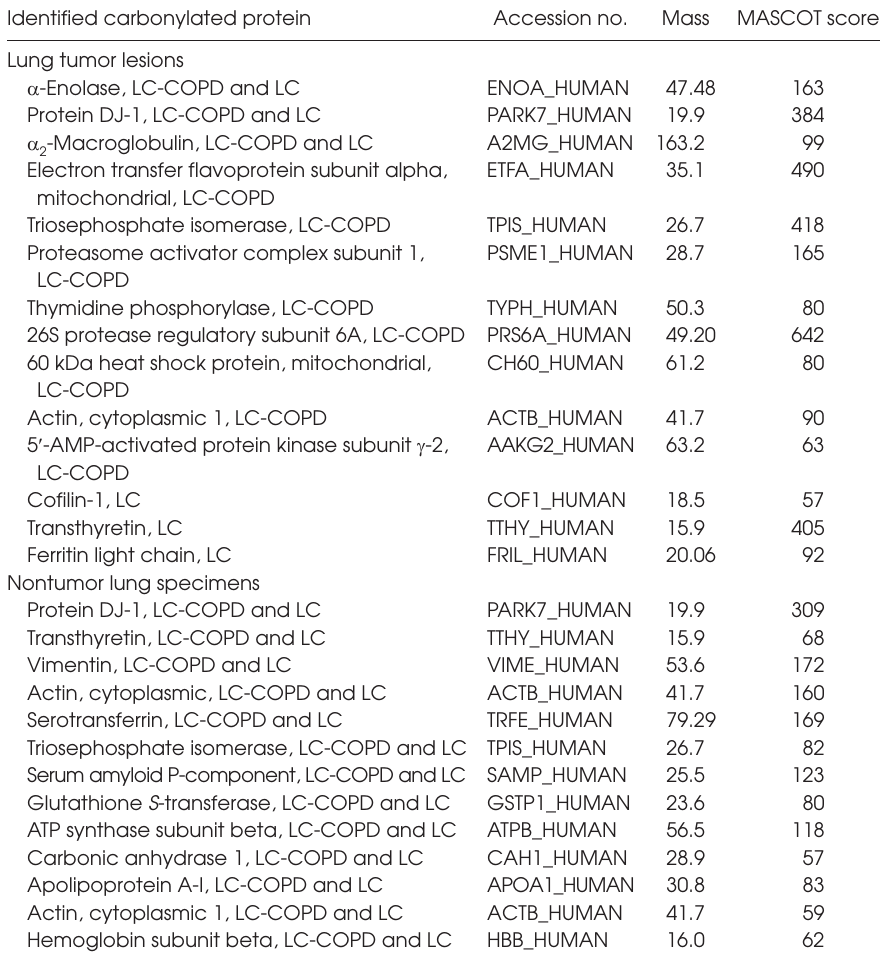
table 3. Identified carbonylated proteins in the lung specimens from the study patients. a